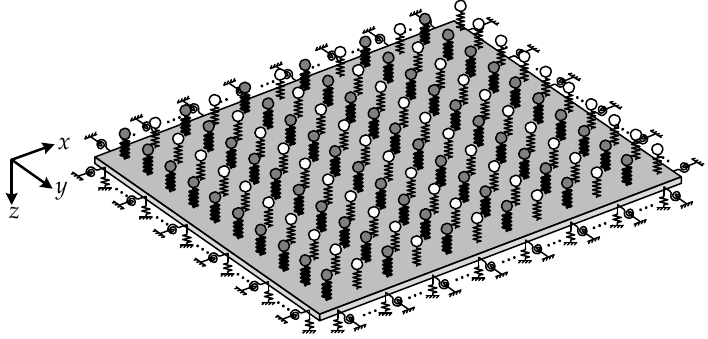
Figure 1. The finite locally resonant plate with elastic boundary conditions.